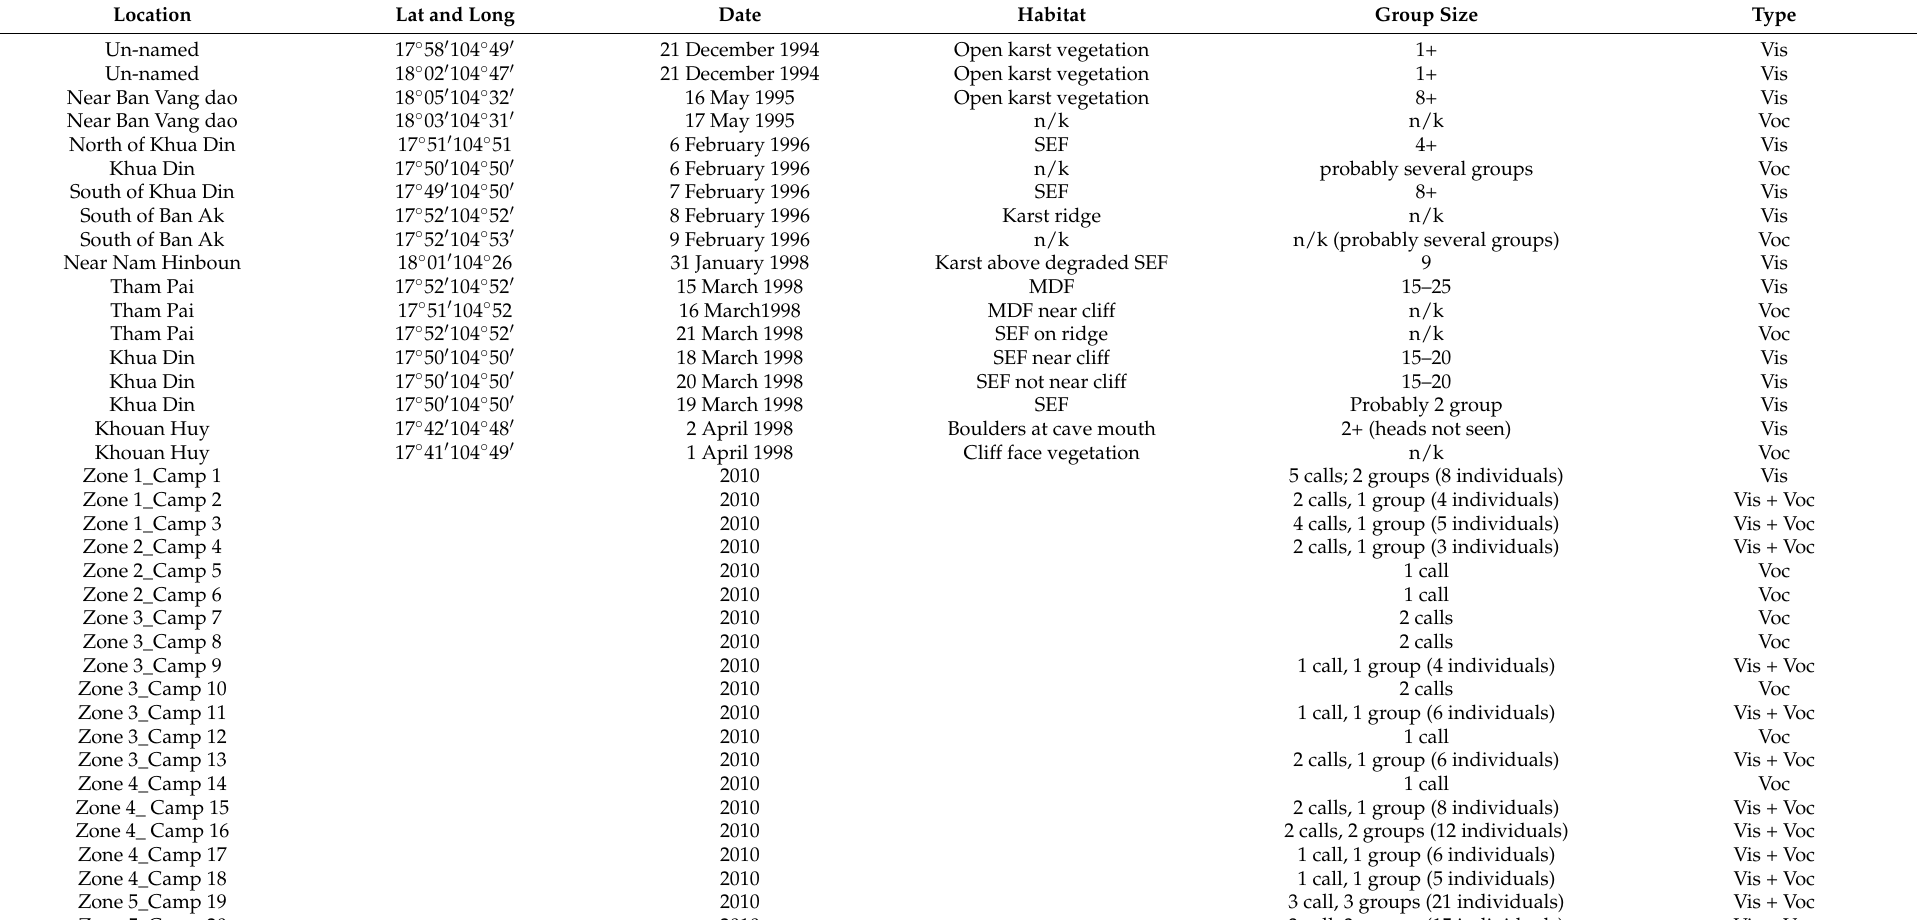
Table 2. Synopsis of the historical records of the Laotian langur in Phou Hin Poun National Protected Area, Lao PDR. Vis = Visual observations; Voc = vocalizations; Lat = latitude; Long = longitude. SEF = semi-evergreen forest; n/k = not known; MDF = mixed deciduous forest. “+” indicates the minimum number of individuals observed in each survey. For instance, 1+ would indicate that at least one individual was observed in that given